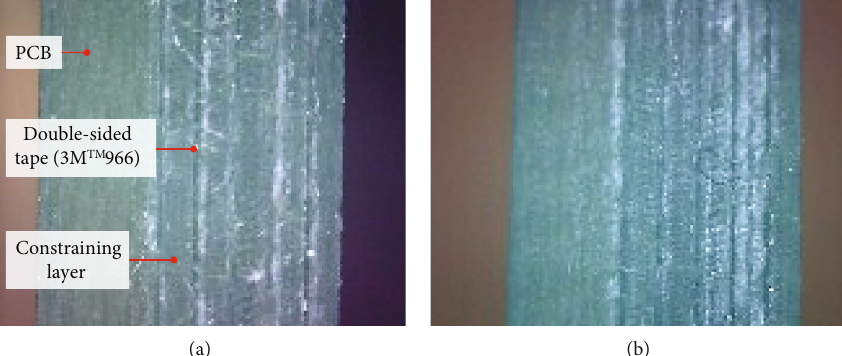
Figure 16: Representative optical microphotographs of the solar panel side edge: (a) before TV environment test and (b) after TV environment test.